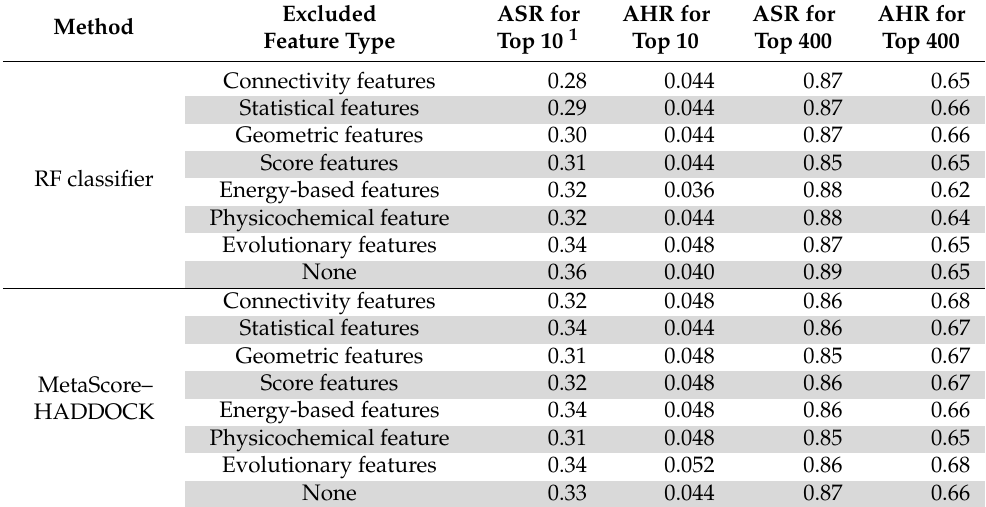
Table 2. Scoring results by subtracting each feature